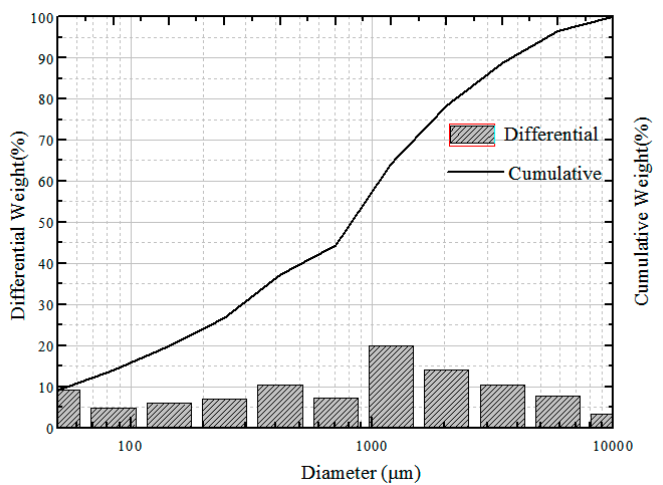
Figure 6. Particle size distribution of powder coke.